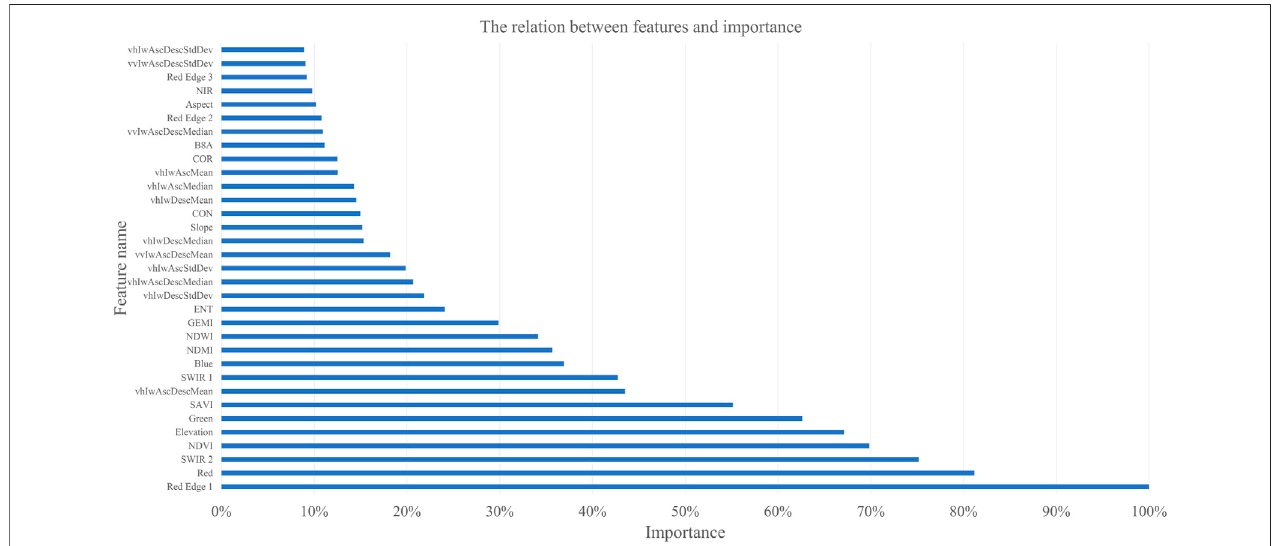
FIGURE 7 | Relation between features and feature importance. The feature importance is listed by the Red Edge 1 set as 100%.